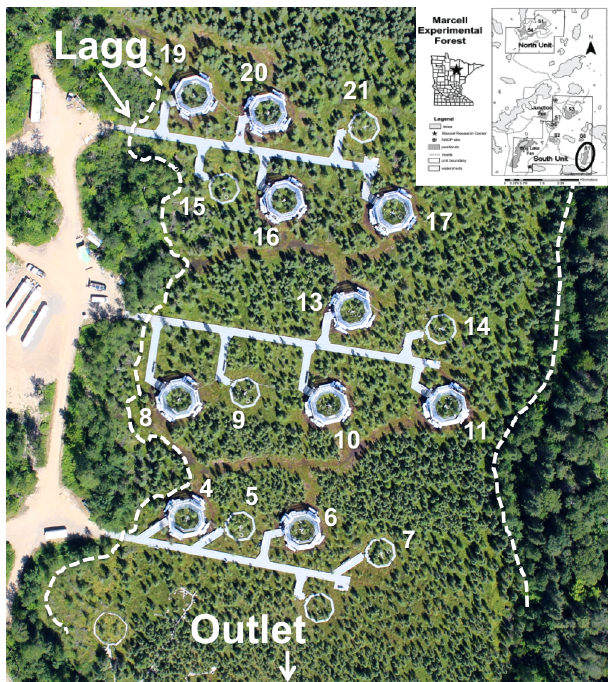
Figure 2. Aerial photograph of the S1 bog showing the 16 experi- mental plots (each 10.4m in diameter to the outer edge of the visible perimeter boardwalk). Plot numbers on the image represent the plot areas within which peat was sampled. The lagg boundary is delin- eated with a dashed line, and the inset indicates the location of the bog within Minnesota and the Marcell Experimental